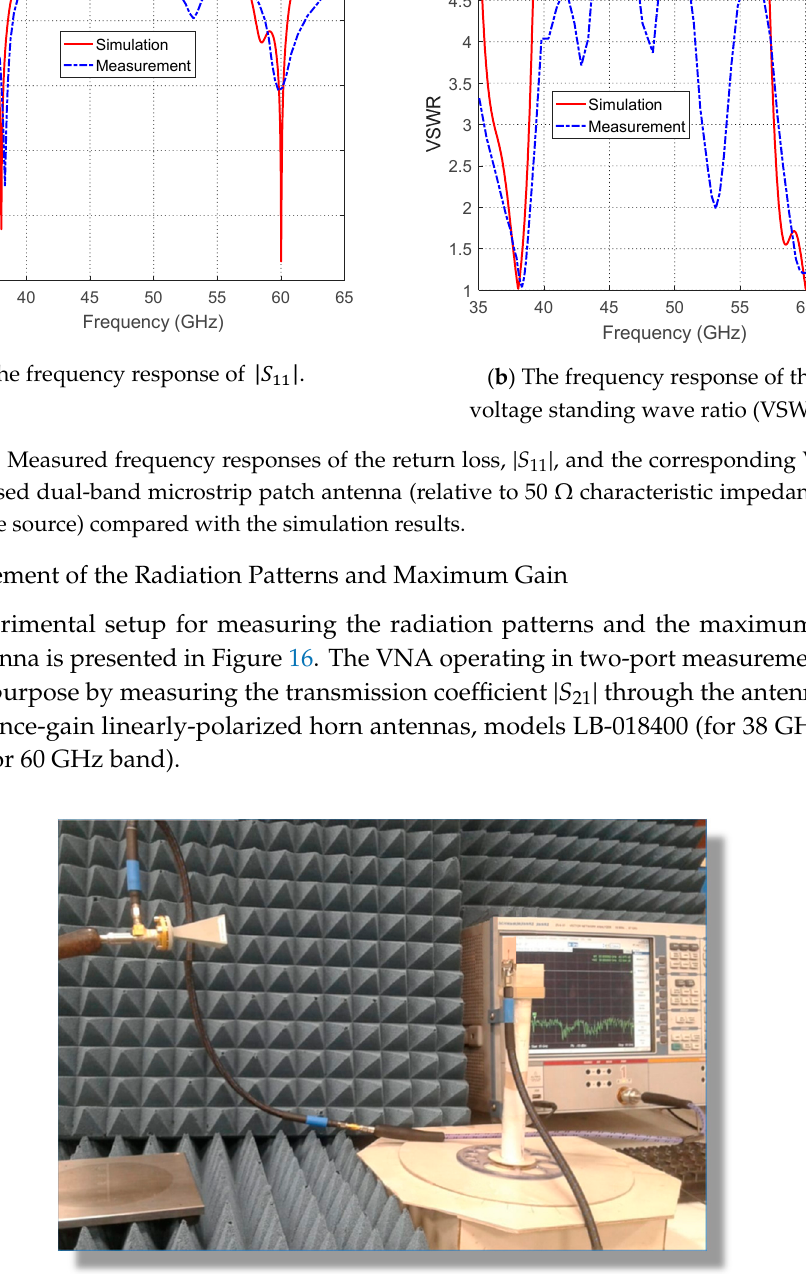
Figure 16. Experimental setup for measuring the radiation pattern and gain of the dual-band antenna. The measured radiation patterns in the elevation planes (cid:2038) = 0° and (cid:2038) = 90° corresponding to